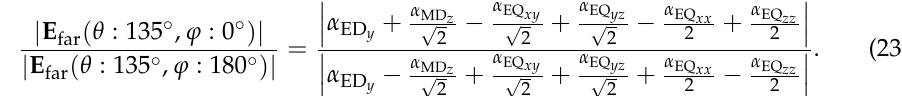
EQ xy , EQ yz , MQ xx , MQ xz , MQ yy , and MQ zz . The complex coefficient of each